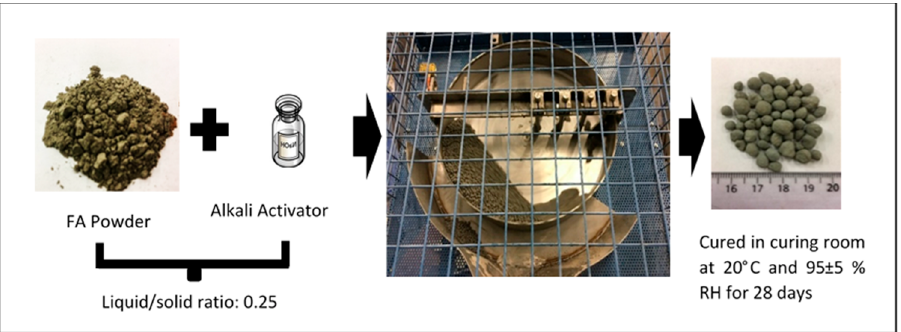
Figure 2. Illustration of the LWA Production.